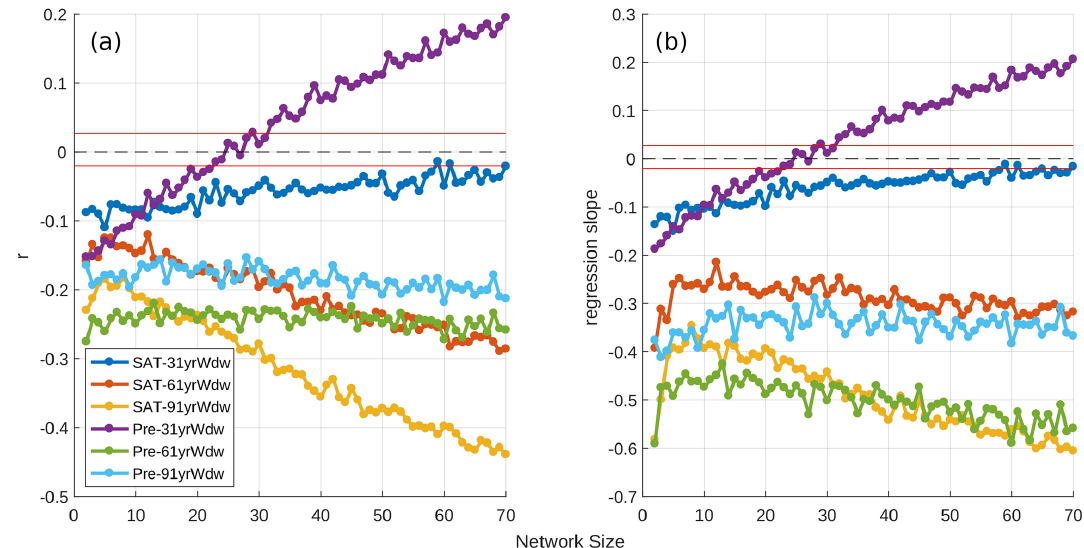
Figure 7. Correlation ( y axis) between the skill of a given reconstruction and the percentage of non-stationary proxies it contains (a) , plotted as a function of network size. (b) is the same as panel (a) , but the y axis shows the regression slope. Calculations are over 10000 reconstructions for each network size. r = 0 is plotted as a dashed black line. All correlations are significant to at least p < 0 . 05, other than in the region bounded by the two red lines about r =